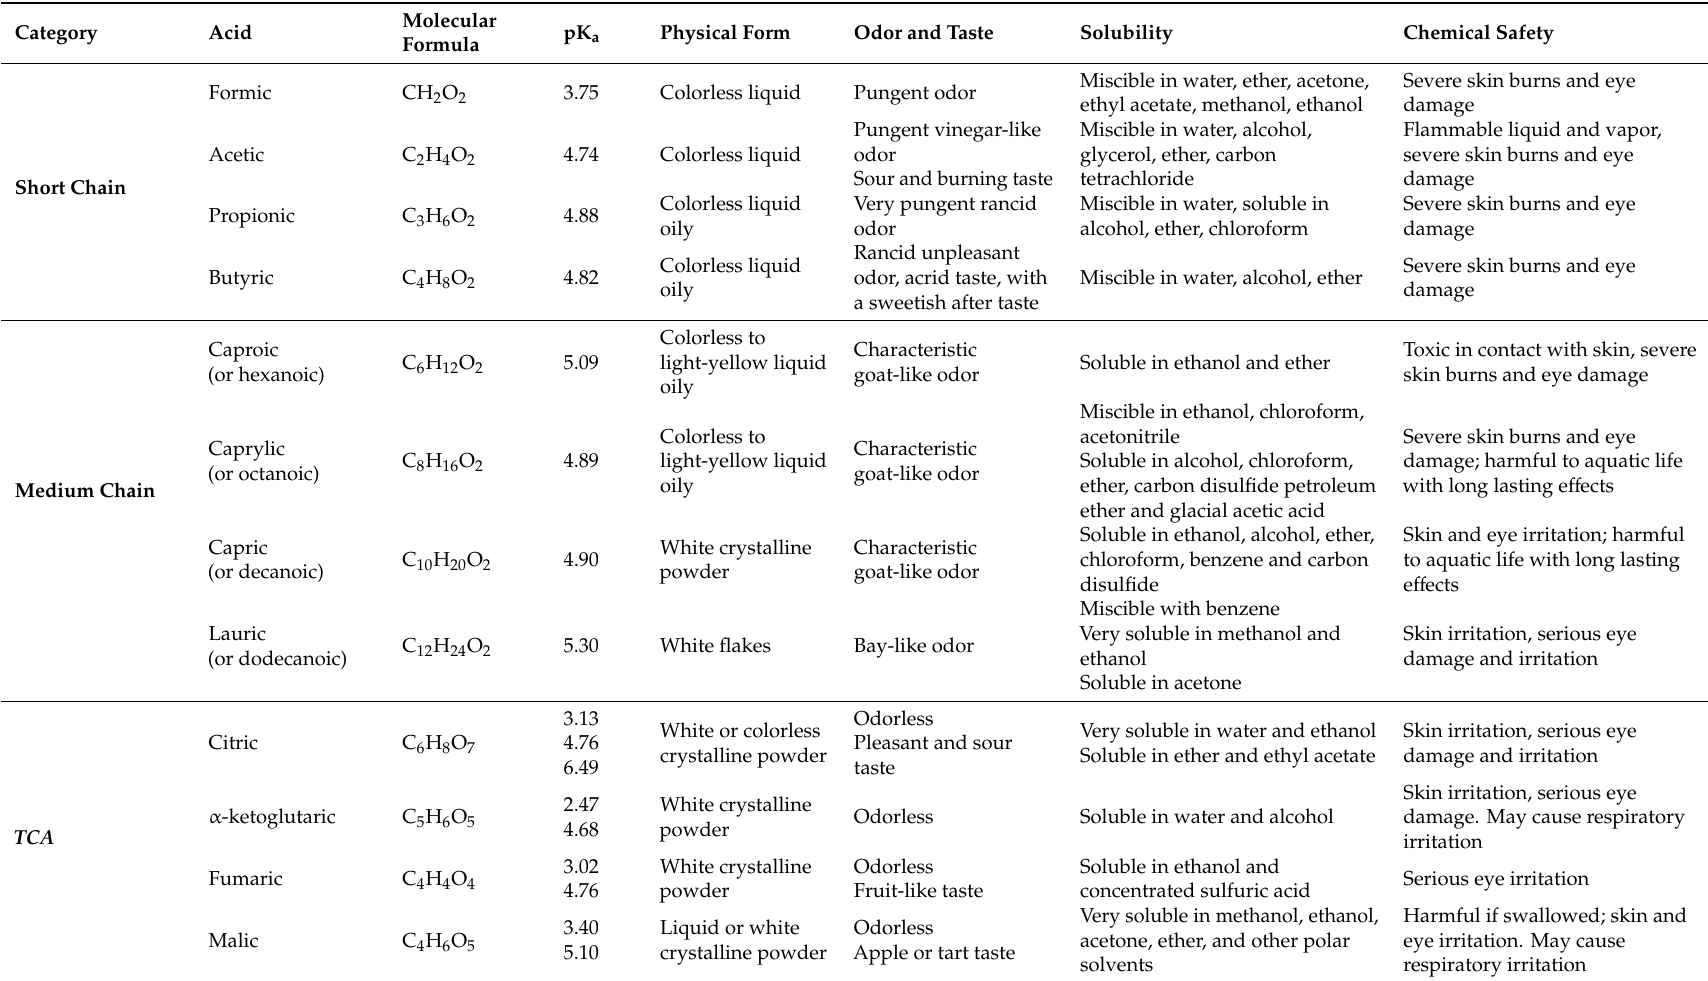
Table 1. List of the most common acids and their